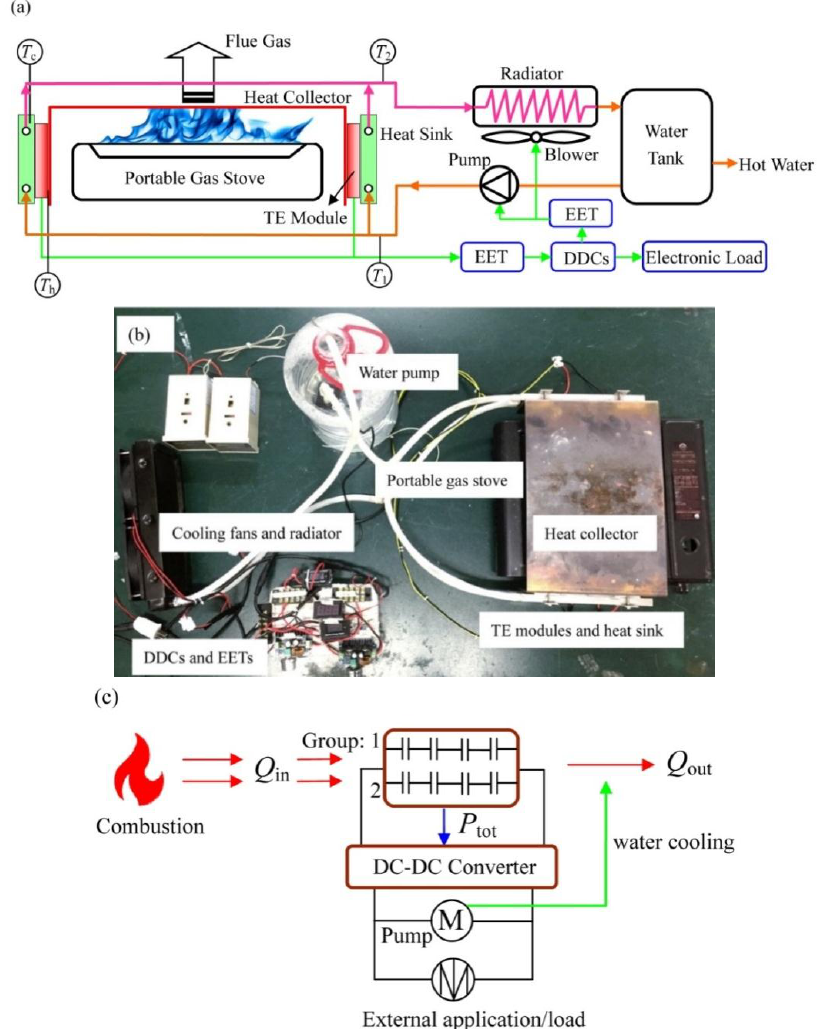
Figure 1. Developed stove-powered thermoelectric generator (SPTEG) based on a portable gas stove. ( a ) SPTEG configuration and experimental setup ( b ) Photograph of the SPTEG ( c ) Electric circuit.